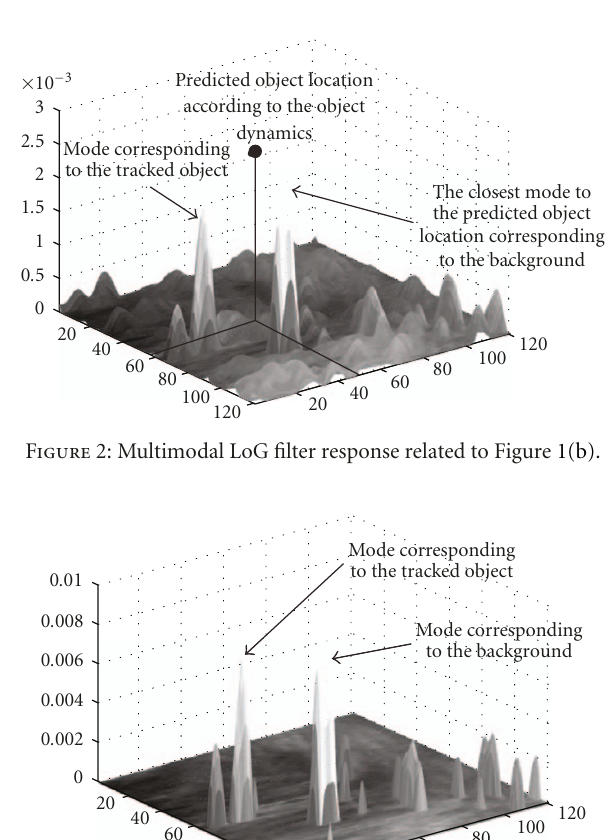
where the function δ ( x ) is Kronecker’s delta, { w i 1, ... , N S } is the set of weights related to the samples, and (cid:8) N S is a normalization factor. As the number of c = w i i = 1 k samples becomes very large, this approximation becomes equivalent to the true posterior